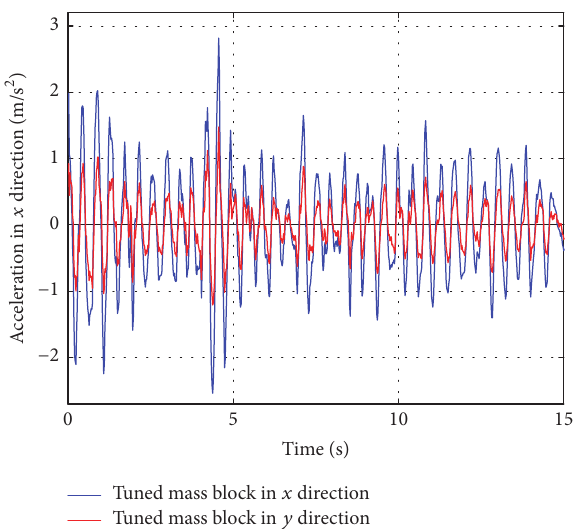
Figure 16: Torsion angle acceleration history of the torsional